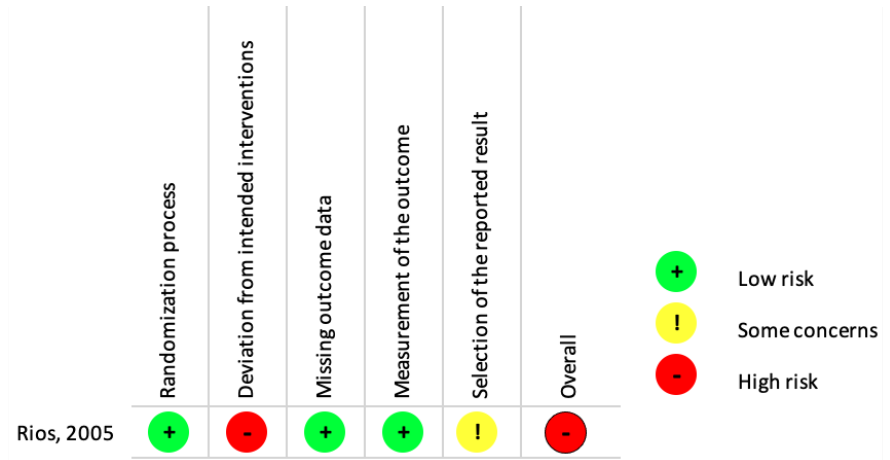
Figure 3. Risk of bias summary-Review of authors’ judgements about each risk of bias item for the included randomized controlled trial